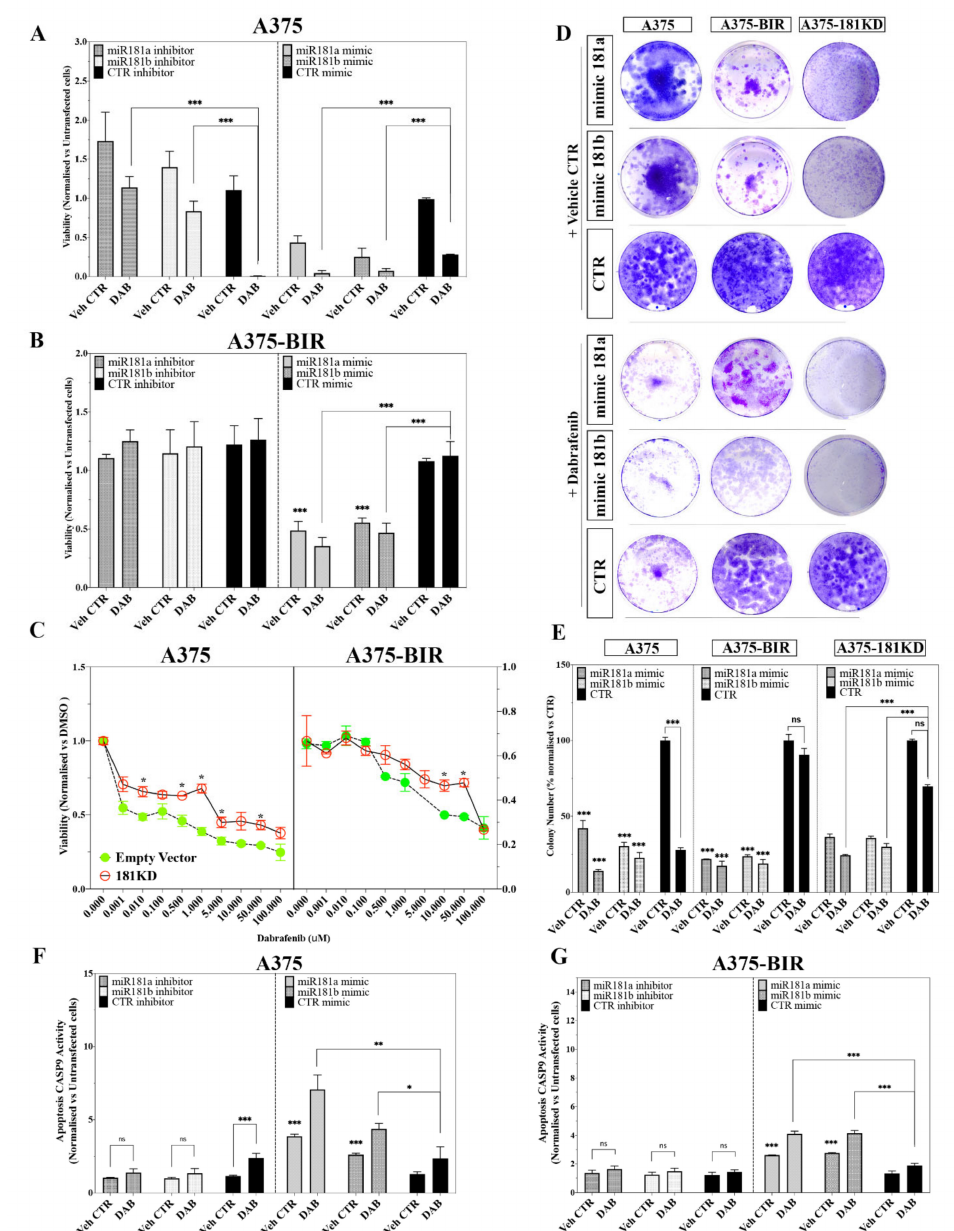
Figure 3. ( A , B ) A375 ( A ) and A375-BIR ( B ) cells transiently transfected with 40 nM of the miR-181a and -181b mimic or inhibitor or the appropriate controls were treated with 200 nM dabrafenib and assayed for proliferation by the MTT assay. Data are expressed in terms of percentage of cell viability as compared to untransfected cells. Each value represents the arithmetic mean of three independent experiments performed with triplicate samples. *** p < 0.001; * p < 0.01. ( C ) Effect of miR-181a/b knockdown on cell proliferation in A375 and A375-BIR melanoma cells treated with increasing doses of dabrafenib. Dose-response curves of cell viability according to the sensitivity to dabrafenib is showed for cells knockdown for pre-miR-181a/b (181KD) cluster and controls bearing empty vector (EV, pcDNA3.1-GFP). Data are represented as mean +/ − SD, n = 3. ( D